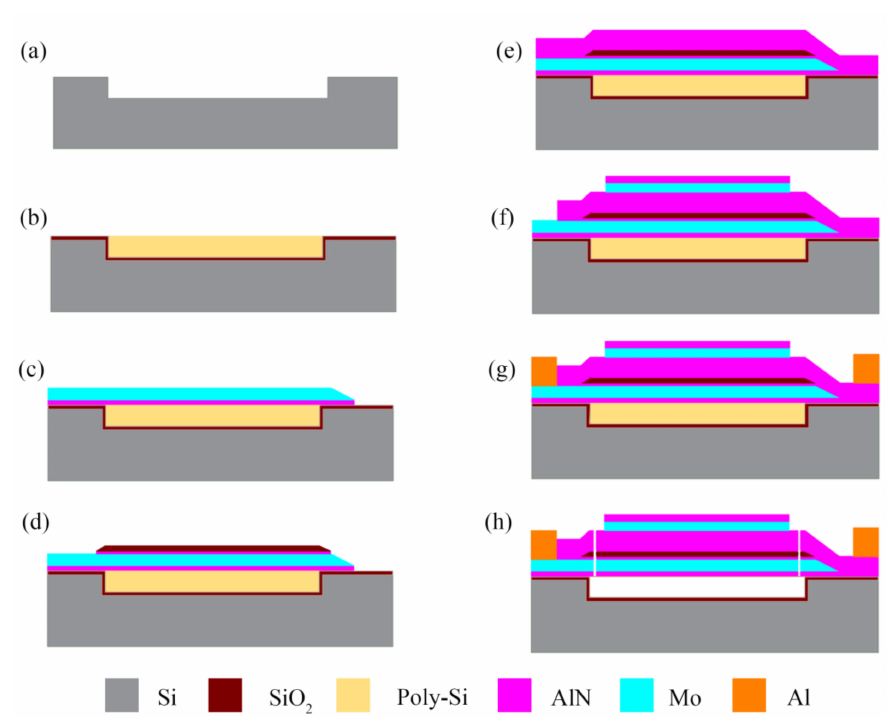
Figure 3. Fabrication process of the TC-FBAR: ( a ) silicon etching; ( b ) thermal oxidation and poly-Si deposition and chemical mechanical polishing; ( c ) AlN seed layer and Mo deposition and etch- ing; ( d ) adhesion layer AlN and SiO 2 temperature-compensated layer deposition and etching; ( e ) piezoelectric layer and AlN deposition; ( f ) top Mo and AlN protective layer deposition and etching; ( g ) Al pad formation; ( h ) AlN etching and polysilicon